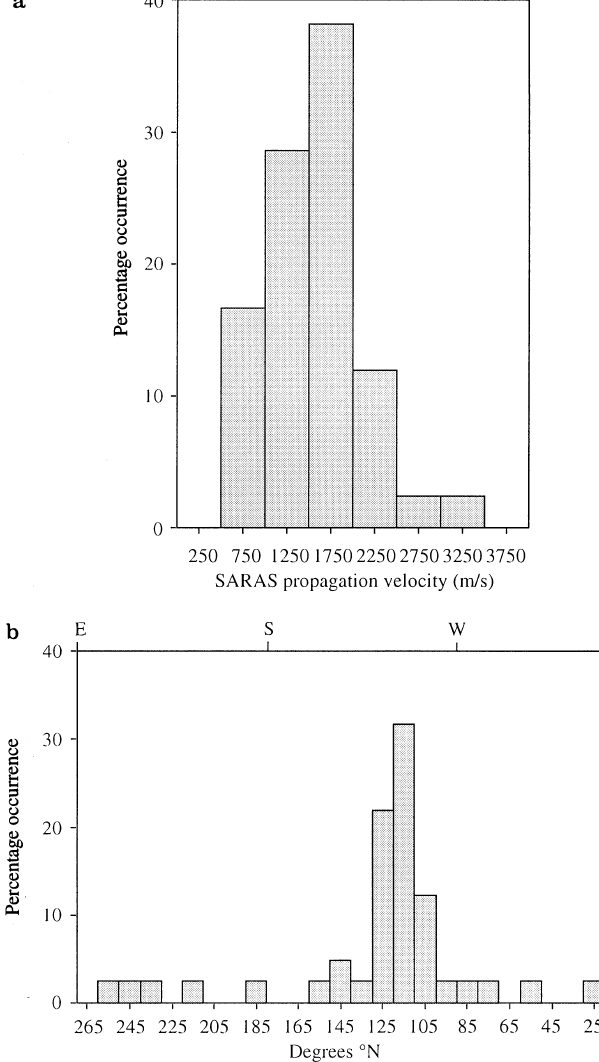
Fig. 5. a Distribution of SARAS propagation velocity expressed as a percentage of SARAS events for which a velocity was determined. b Percentage occurrence of the SARAS propagation direction, the angle in degrees is given as a westward bearing from geographic